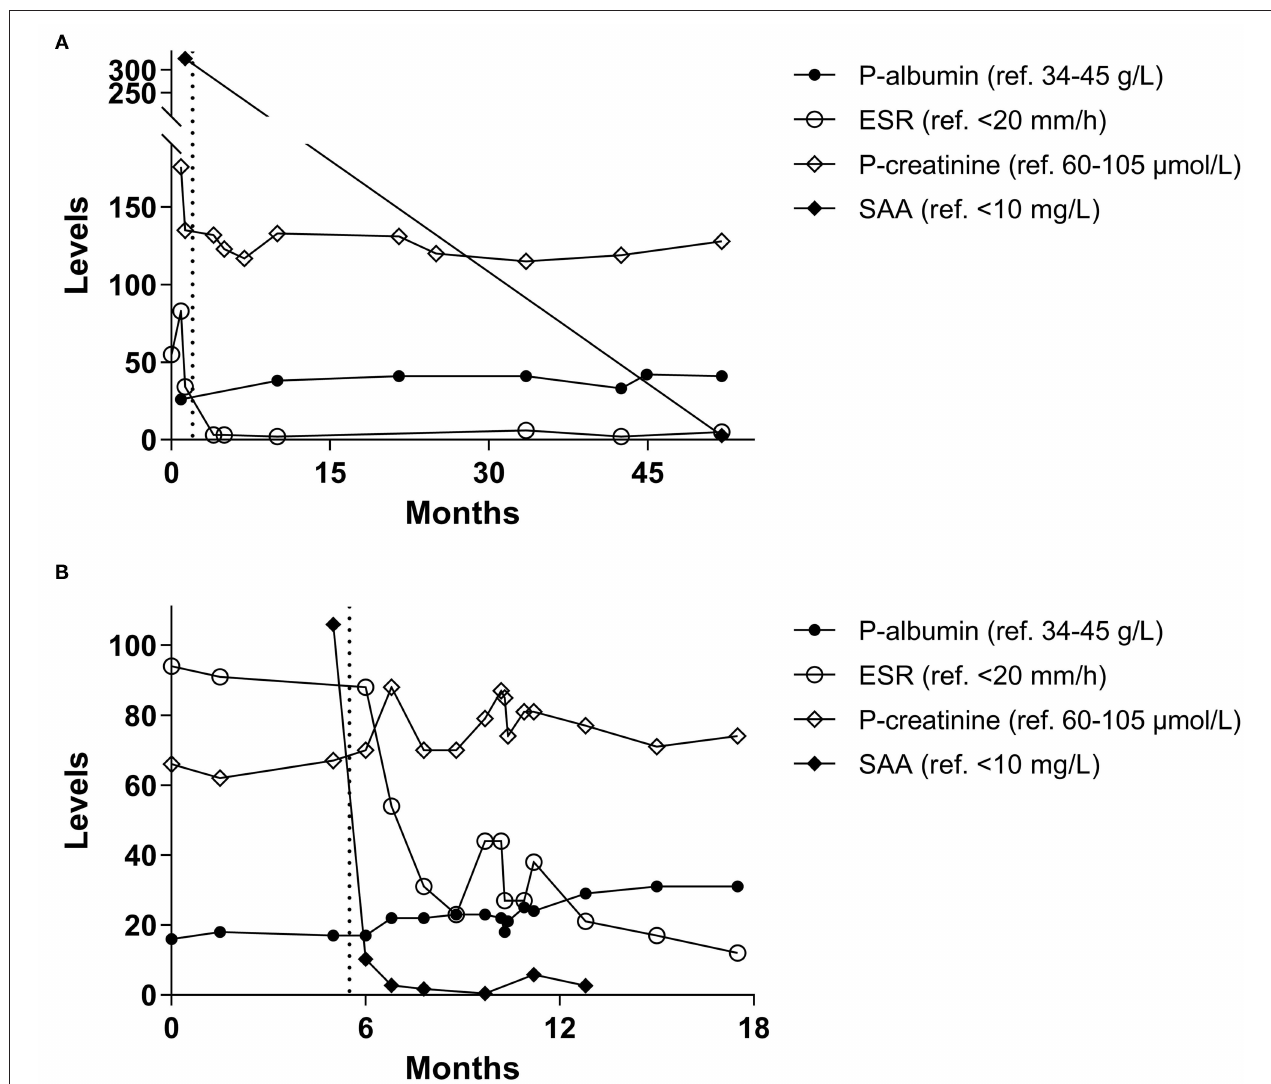
FIGURE 1 | (A) Longitudinal laboratory data from the first clinical case with albumin and creatinine in plasma (P–), erythrocyte sedimentation rate (ESR), and serum amyloid A (SAA). (B) Longitudinal laboratory data from the second clinical case. Months indicate time since onset of proteinuria and the dotted line illustrates time-point of first tocilizumab